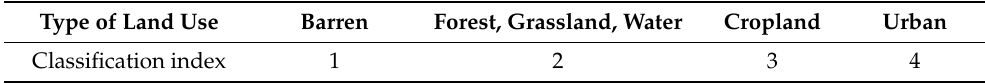
Table 1. The classification values of land use degree. Type of Land Use Barren Forest, Grassland,